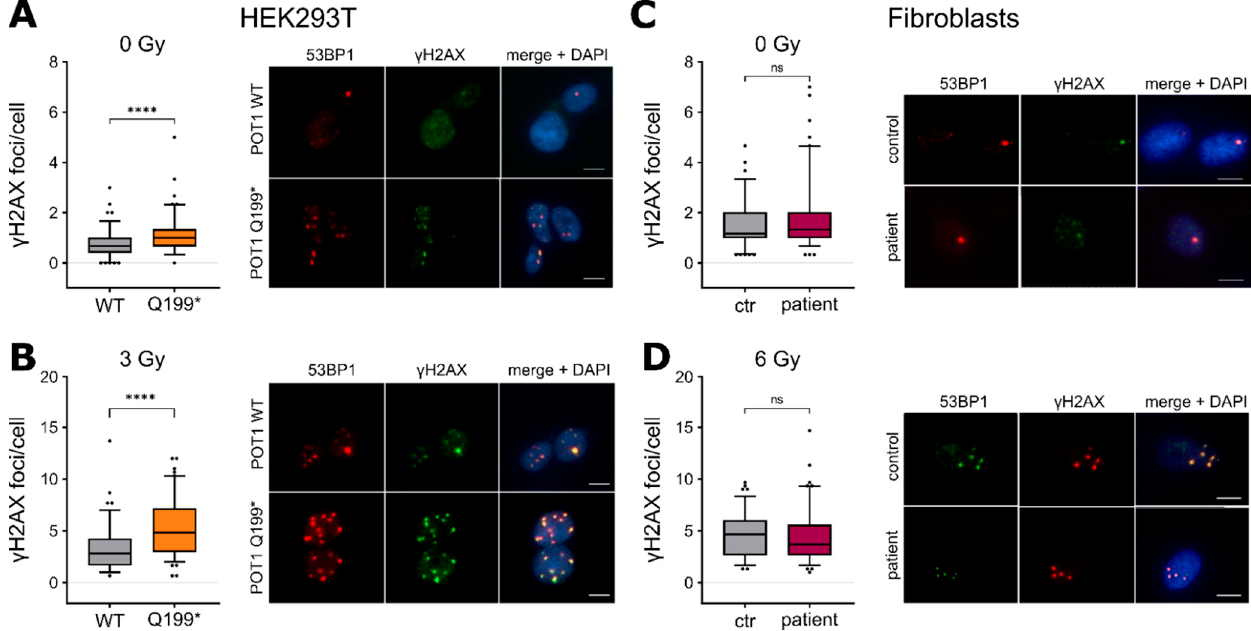
Figure 3. ( A ) Left: Quantification of the yH2AX foci per cell in the HEK293T POT1 WT and POT1 p.Q199* cells. Right: Representative images of the yH2AX (green) and 53BP1 (red) foci. DAPI (blue) was used for DNA labeling. Scale bar: 10 µm. ( B ) Left: quantification of yH2AX foci per cell in HEK293T POT1 WT and POT1 p.Q199* cells. The cells were exposed to 3 Gy ionising radiation. Right: Representative images analogous to ( A ). ( C ) Immunostaining analogous to ( A ) in the primary fibroblasts of the patient. ( D ) Immunostaining analogous to ( A ) in the primary fibroblasts of the patient with the cells exposed to 6 Gy ionising radiation. The experiments were performed as three biological replicates. The values are expressed in boxplots with whiskers from percentile 5–95. For the statistical analysis, two-tailed Student’s unpaired t -test was performed. ns = p > 0.05, **** = p ≤ 0.0001. ctr =